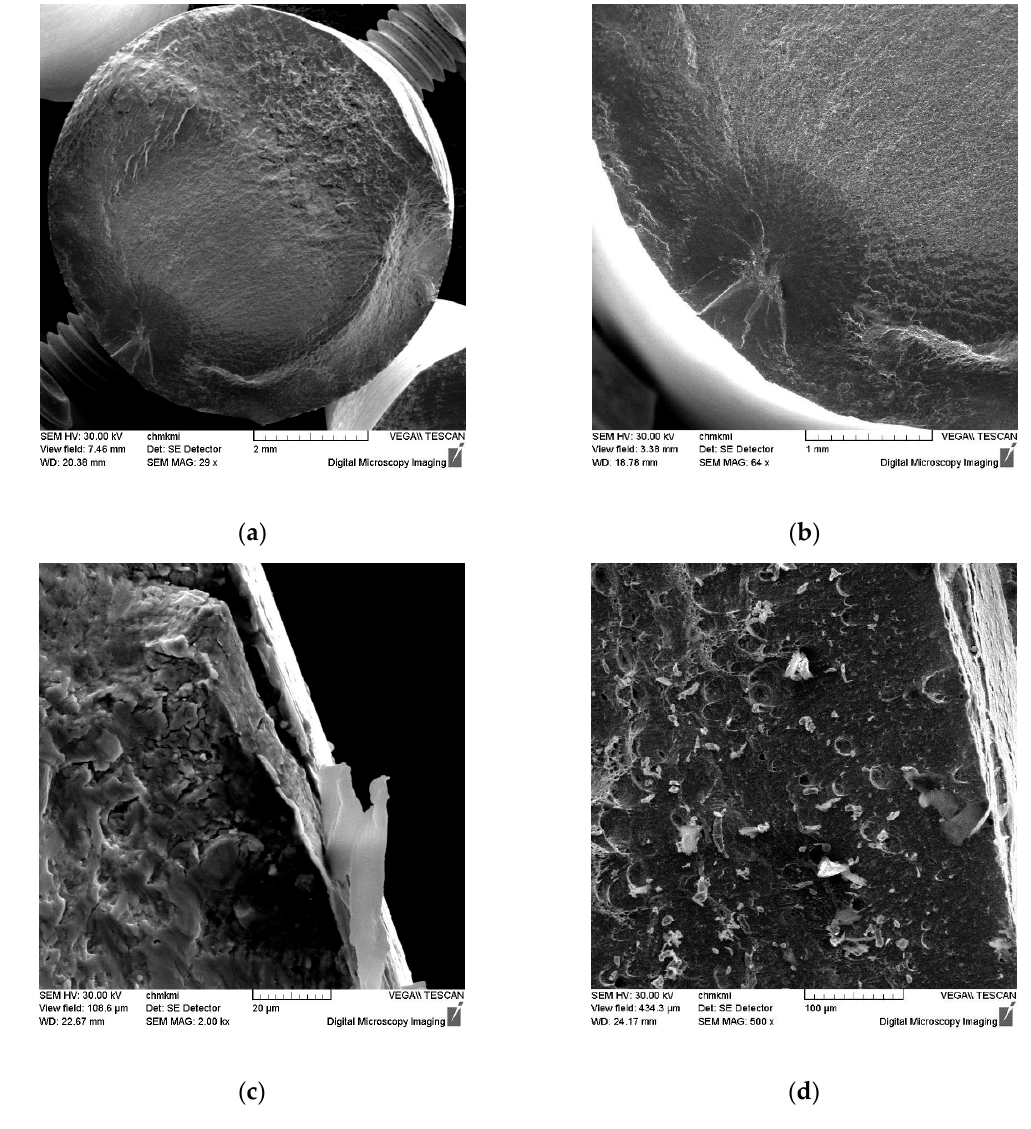
Figure 14. Fracture surface of UIP 2 × 85 N Strenx 700 MC specimen loaded at 415 MPa and fractured after 3.23 × 10 7 cycles: Overall view of the fracture ( a ), detail of fish-eye fatigue crack initiation ( b ), delamination of the strengthened surface layer ( c ) and final fracture with area of finer dimples in the strengthened surface layer ( d ).